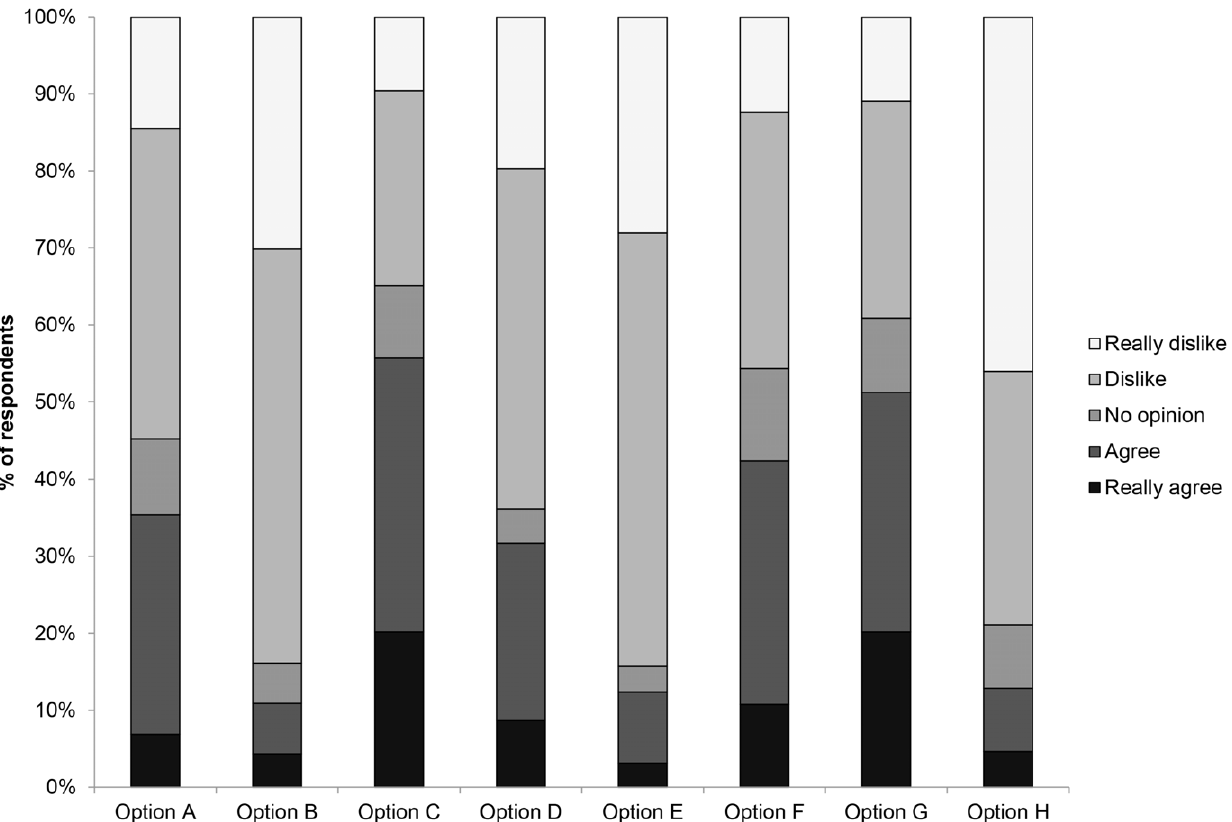
Figure 7. Percentage of respondents that agreed with, disagreed with or had no opinion of potential cat management options: A - people living near ecologically sensitive areas should not own cats; B – town/city residents should not own cats; C – cats should be fitted with a bell or other anti-predation device; D – cats should remain within their owner’s garden; E – cats should be confined during the day; F – cats should be registered with the local council; G – cats should undergo compulsory sterilisation; H – cats should be de-clawed.